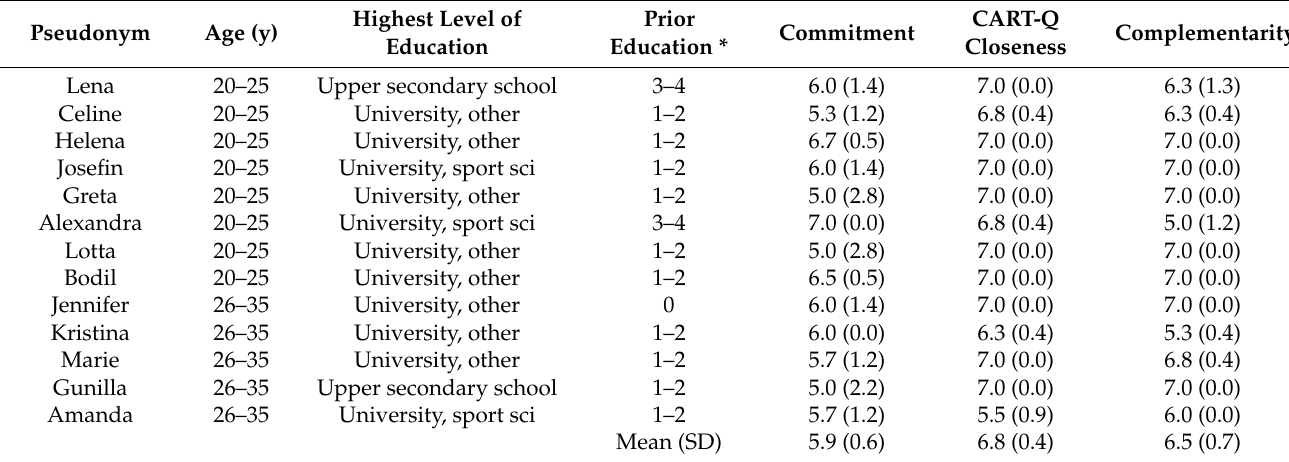
Table 1. Descriptive data for the female athletes relating to age, educational level, prior education * and mean (standard deviation, SD) coach–athlete relationship (CART-Q) scores.